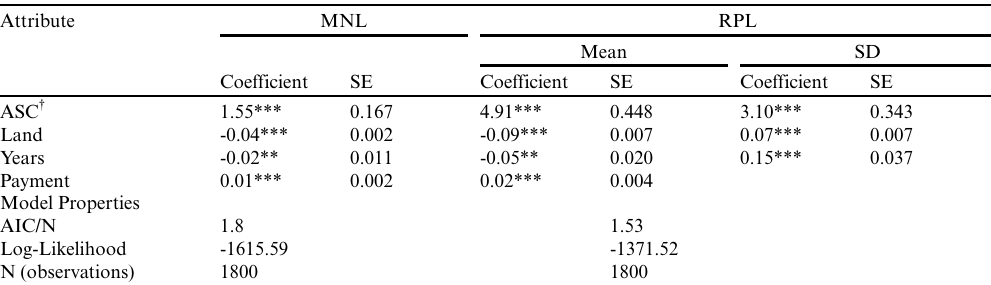
Table 3. Estimated beta coefficients from multinomial logit (MNL) and random parameter logit (RPL) analysis from choice experiment surveys conducted in the buffer area of Pench Tiger Reserve, India in 2018– 2019. The MNL model assumes homogeneity in preferences, with a single beta estimate associated with each attribute. The RPL model assumes heterogeneity in preferences; ASC, Land and Year are considered as normally distributed random variables, yielding a distribution of beta estimates, with a mean and